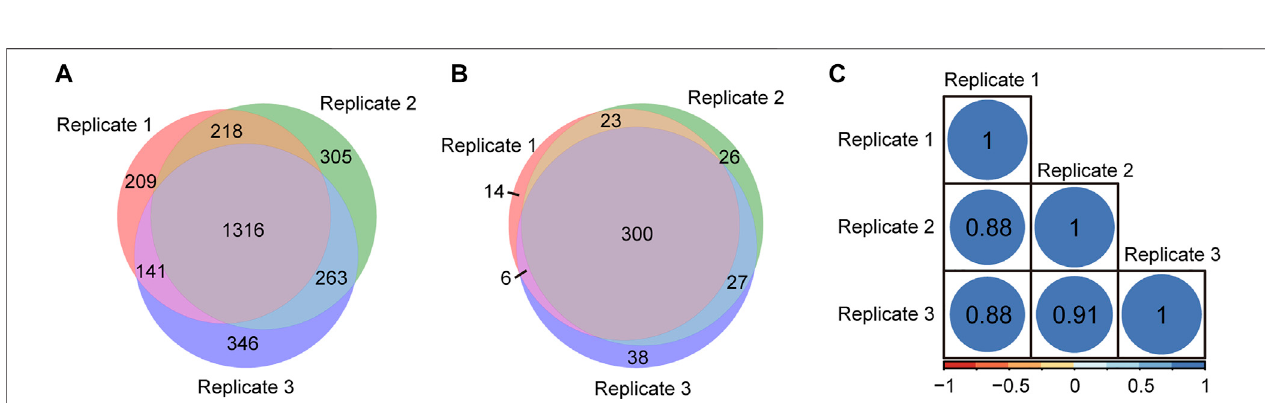
FIGURE 5 | N-glycopeptides and N-glycoproteins identi fi ed from three replicates of tandem enrichment. (A) Identi fi cation reproducibility of N-glycopeptides. (B) Identi fi cation reproducibility of N-glycoproteins. (C) Quanti fi cation reproducibility of N-glycopeptides